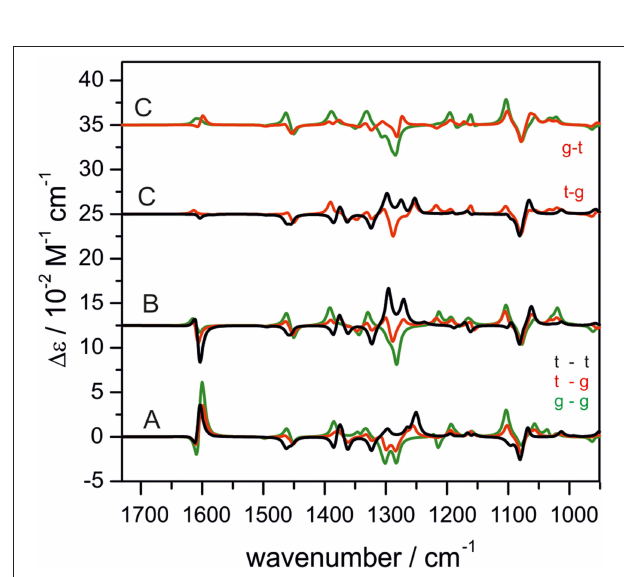
FIGURE 5 | The calculated single conformer VCD spectra of the dimer of methyl-benzyl-amide borane adopting three binding topologies shown in Figure 4. Reproduced with permission from Merten et al. (2014a,b). Copyright 2014, Wiley-VCH Verlag GmbH & Co. KGaA,